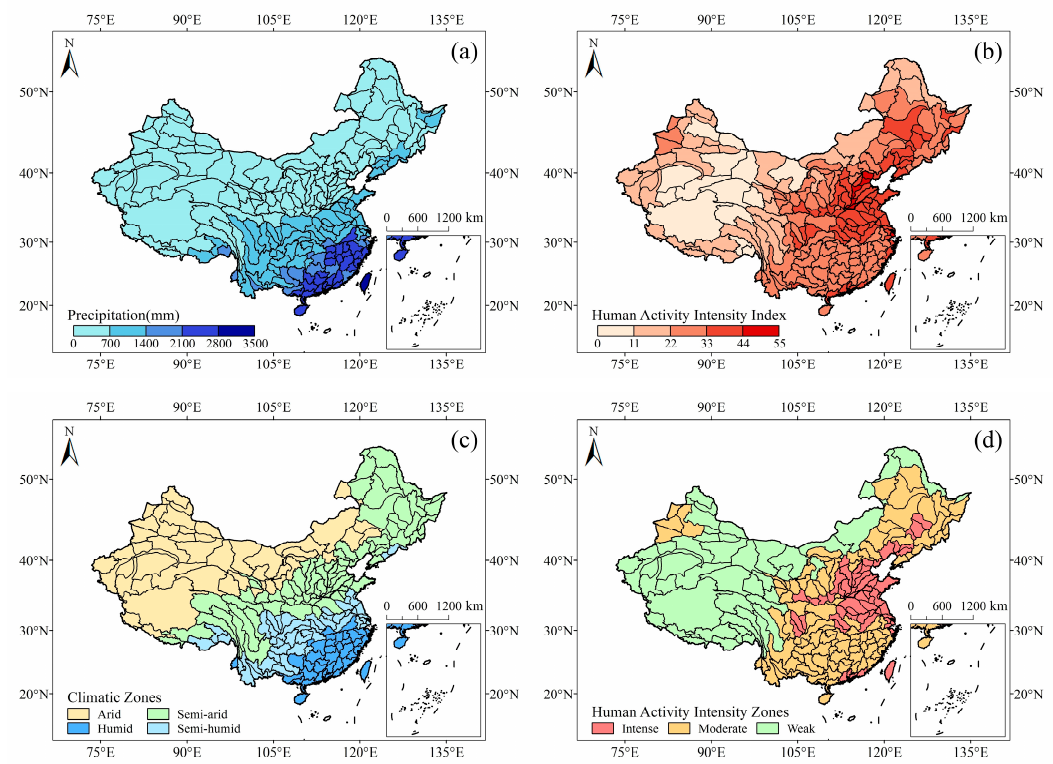
Figure 2. Maps depicting the spatial variations of ( a ) mean annual precipitation, ( b ) human activity intensity, and their clustered zones determined by the K-means clustering algorithm in ( c ) and ( d ), respectively.